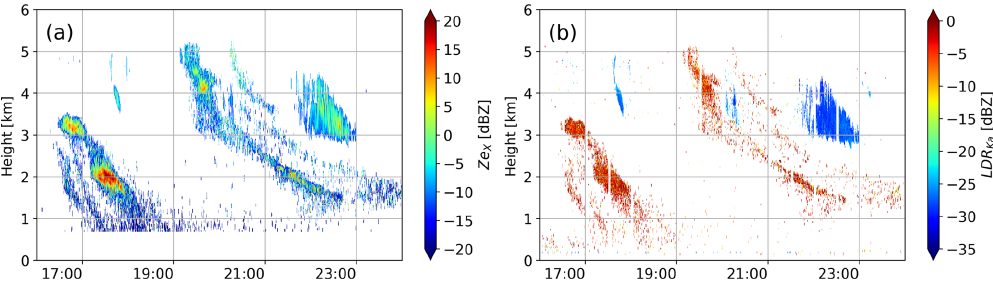
Figure 6. Time–height plots of the Ze X and LDR Ka of 23 November 2015 between 16:00 and 23:59. The region where the LDR is ≈ − 5dB is most probably the result of chaff. The Ka band software applies a filtering for non-meteorological targets which removes most of the chaff; only the filtered Ka band data are included in the TRIPEx dataset. Note that no such filtering is applied to the X band and W band data.